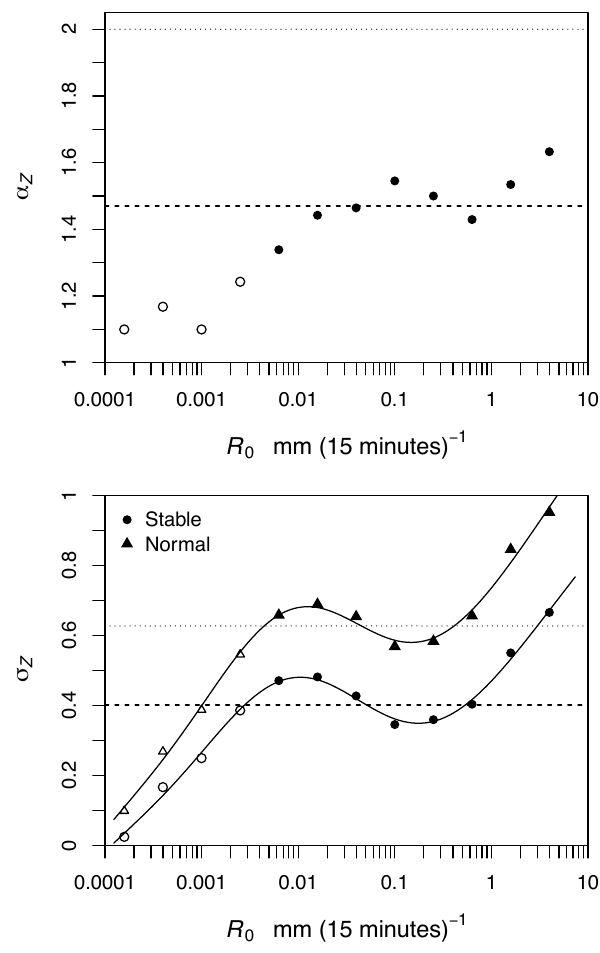
Fig. 5. Estimated stable distribution parameters α Z and σ Z for Z = ln Y + against large-scale areal-averaged rainfall rates R 0 for R 0 > 0. The open symbols indicate where estimation was clearly affected by artifacts arising from data precision. In the upper panel, the dashed line shows the estimate of α Z using all data for R 0 ≥ 0 . 004mm (15-min) − 1 and the dotted line is σ Z =2 (the normal distribution). In the lower panel, values of σ Z assume constant α Z =1.47 and α Z =2 for the stable and normal distribu- tions, respectively. The solid curves are fitted cubic spline func- tions. The dashed and dotted horizontal lines indicate the values of σ Z averaged over all R 0 ≥ 0 . 004mm for the stable and normal distribution,